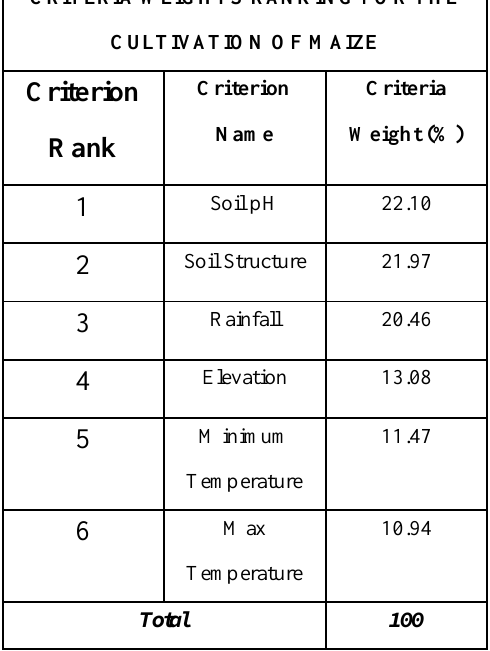
Table 2. Criteria weights ranking for the cultivation of